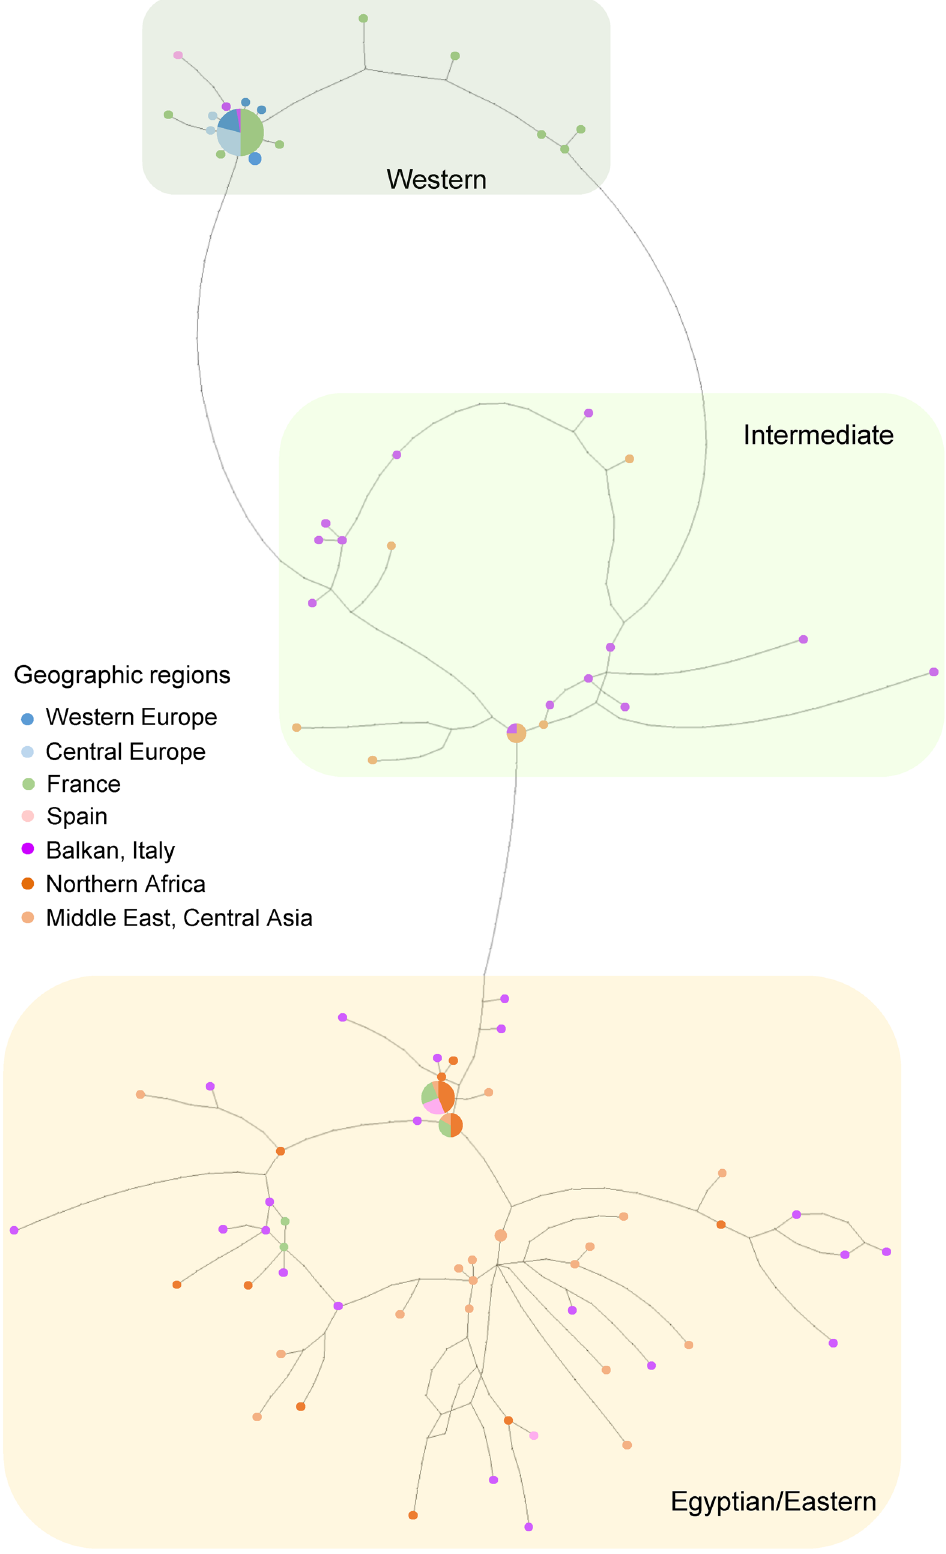
Figure 1. Statistical parsimony network of mitochondrial COI - tRNA Leu - COII and Cyt b-tRNA Ser -ND1 of Hypera postica in its native range. Generated using TCS 1.21 80